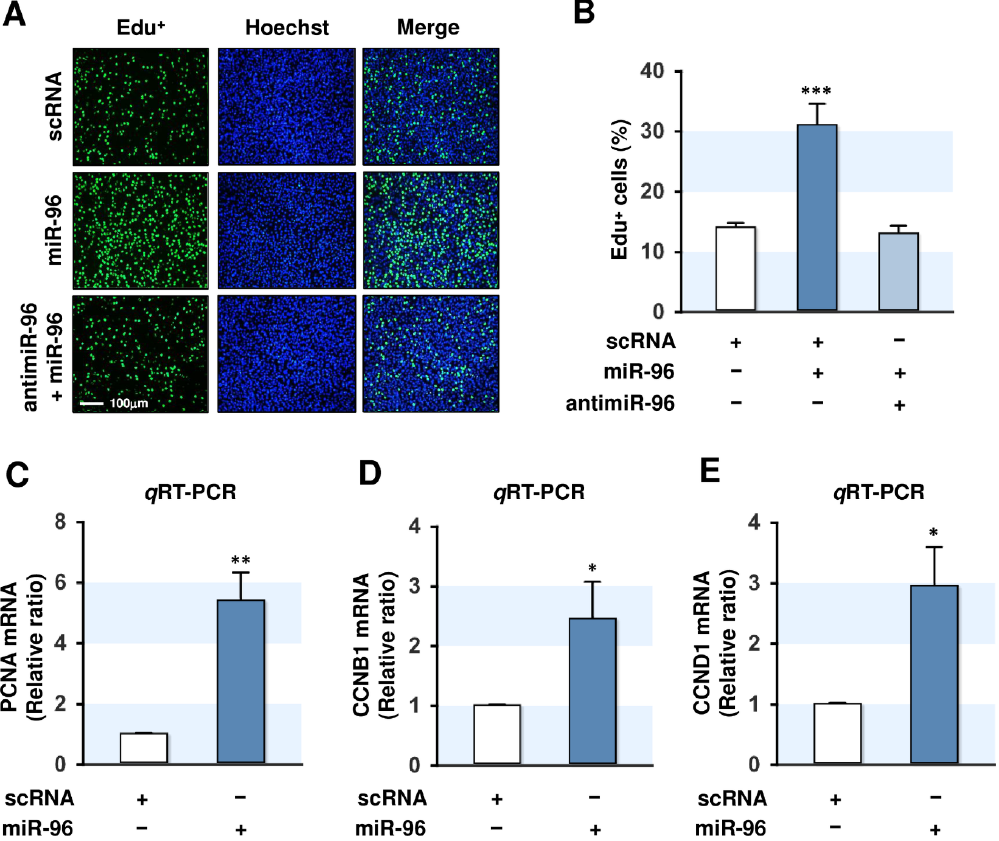
Figure 4. MiR ‐ 96 ‐ 5p stimulates the proliferation of C2C12 myoblasts. C2C12 myoblasts were transfected with 100 nM of scRNA control, miR ‐ 96 ‐ 5p mimic, or antimiR ‐ 96 ‐ 5p. ( A ) After 24 h of transfection, the cells were labeled with 10 μ M of EdU (green) for 4 h, and nuclei were stained with Hoechst (blue). ( B ) Percentages of EdU ‐ positive cells were analyzed by ImageJ software. ( C – E ) q RT ‐ PCR analysis of PCNA, CCNB1, and CCND1 expression at 24 h after transfection with 100 nM of scRNA control or miR ‐ 96 ‐ 5p mimic. The level of expression was normalized to the amount of U6. The values are expressed as the relative ratio, where the intensity of normalized scRNA control was set to one. Results are expressed as means ± SEMs ( n > 3). *, p < 0.05; **, p < 0.01; ***, p < 0.001 vs. scRNA.